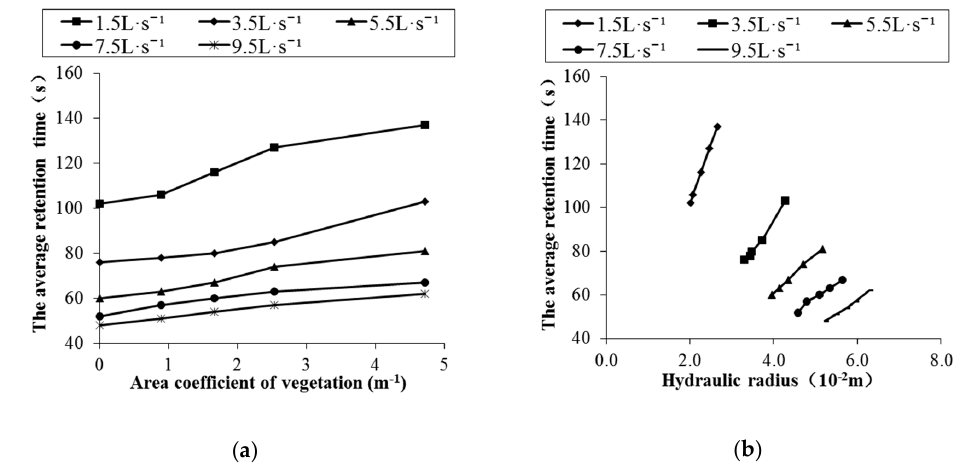
Figure 4. The effect of various factors on the average retention time under different flow rates: ( a ) area coefficient; ( b ) hydraulic radius.